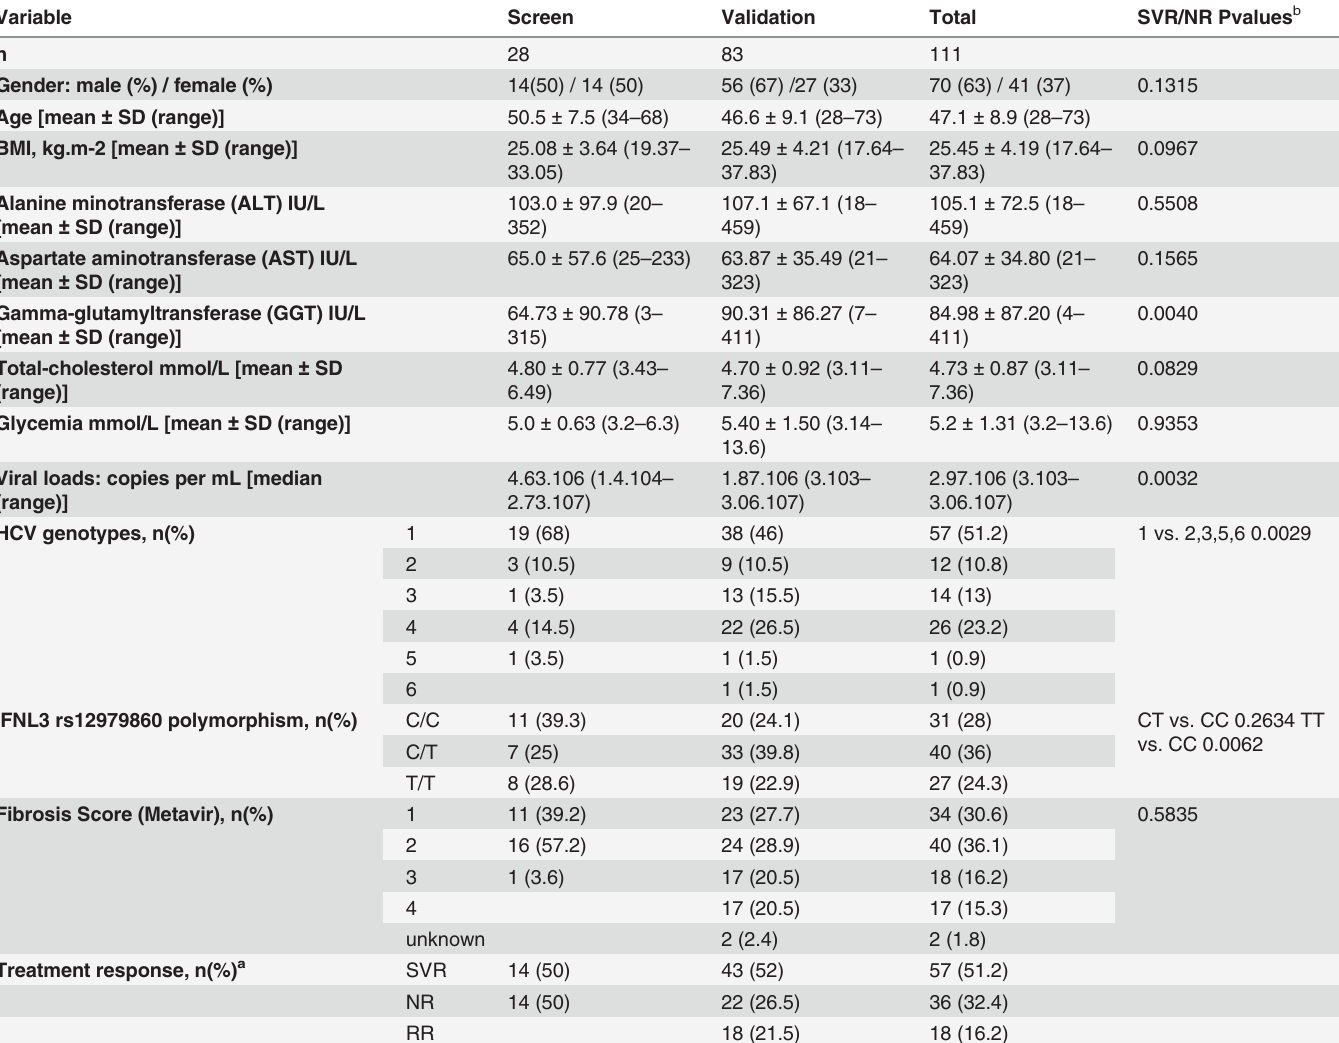
Table 1. Characteristics of the